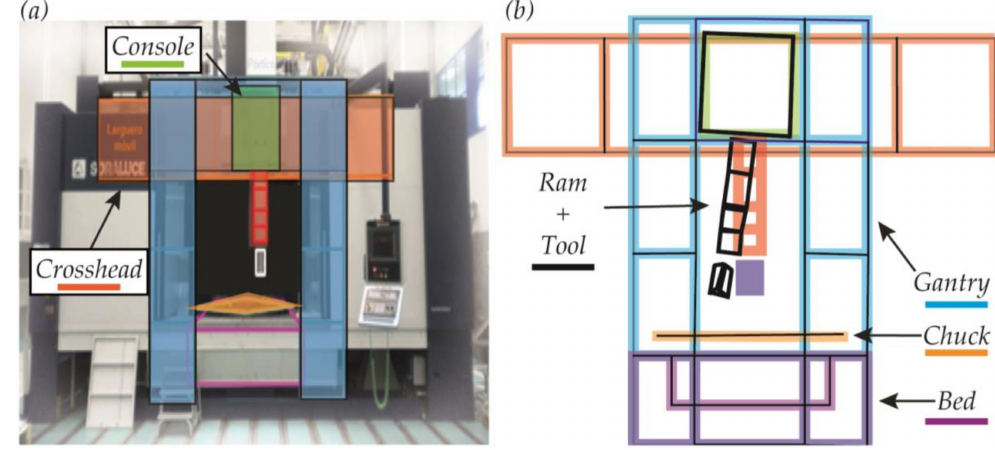
Figure 4. ( a ) Machine modal analysis description, ( b ) Ram mode displacement.